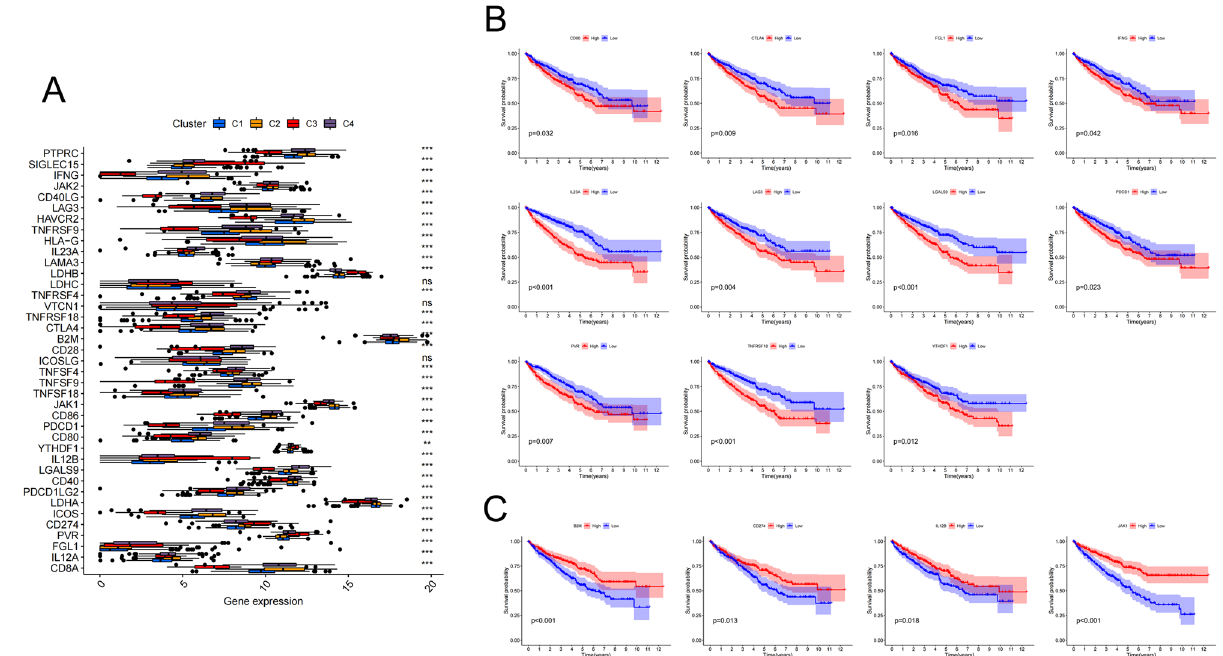
Figure 6. Comprehensive analysis of ICGs in four molecular subtypes. ( A ) Differential expression analysis of 39 ICGs. ( B ) Kaplan–Meier survival plots of ICGs with a poor prognosis. ( C ) Kaplan–Meier survival plots of ICGs with a promising prognosis. The blue curve represents the low-expression group, and the red curve represents the high-expression